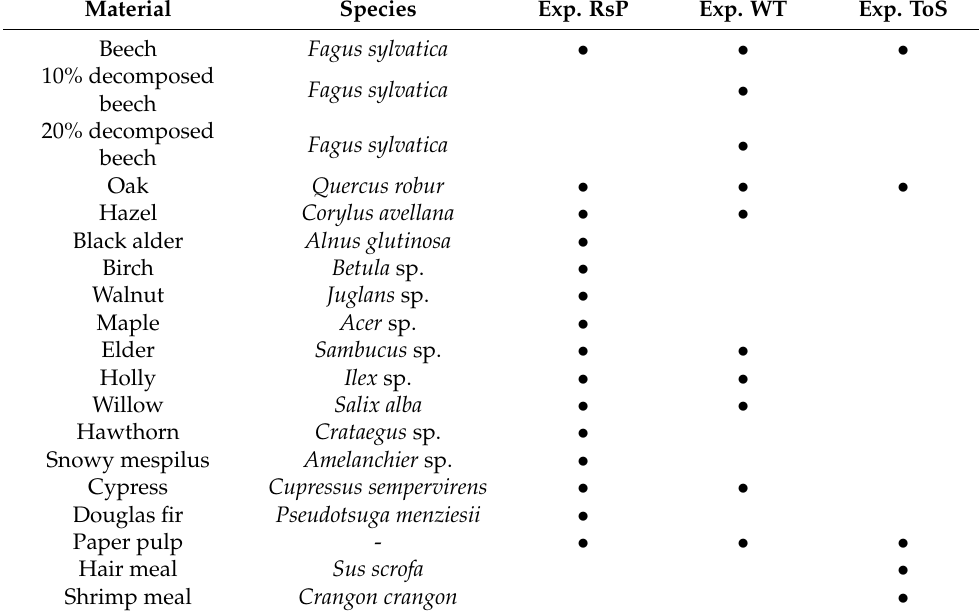
Table 1. Wood types and organic materials used in this study in the three experiments: RsP ( R. solani performance on organic materials in a Petri dish assay), WT (bioassay with soil amended with distinct wood types), and ToS (bioassay investigating the effect of organic amendments and the use of three times of sowing after amendment). Materials utilized in each experiment are indicated